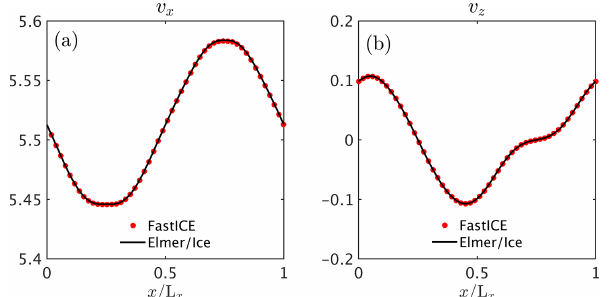
Figure 6. Non-dimensional simulation results for the 2-D configu- ration of Experiment 2. We plot (a) the horizontal surface velocity component v x and (b) the vertical surface velocity component v z across the slab for both our FastICE model and Elmer/Ice. In di- mensional terms, the maximum horizontal velocity ( v x ≈ 5 . 58) cor- responds to ≈ 16 . 9myr − 1 . The horizontal distance is 10km, while the ice thickness is 1km. The box is inclined at 0.1 ◦